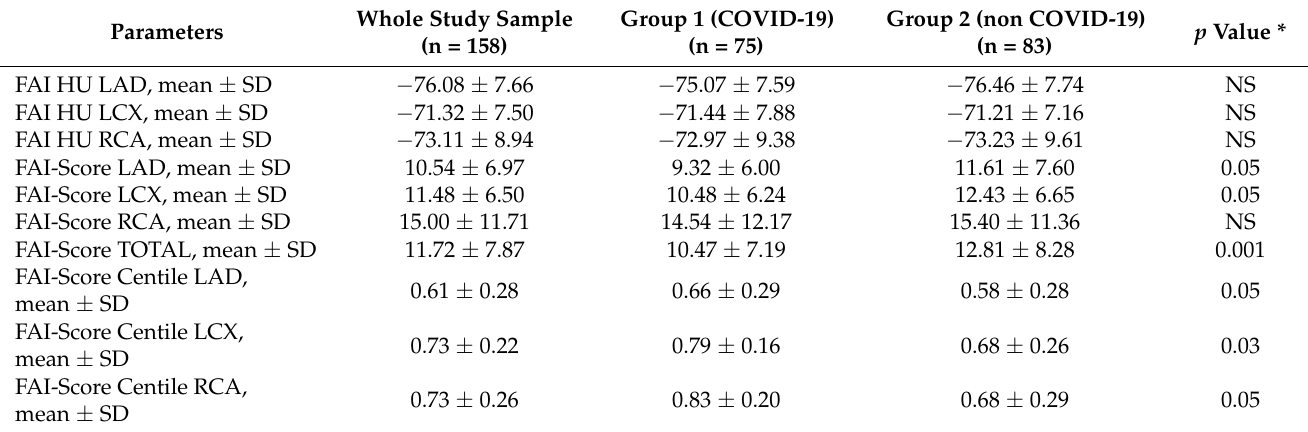
Table 2. PVAT-FAI Score Centile of Coronary Inflammation for Age and Gender.